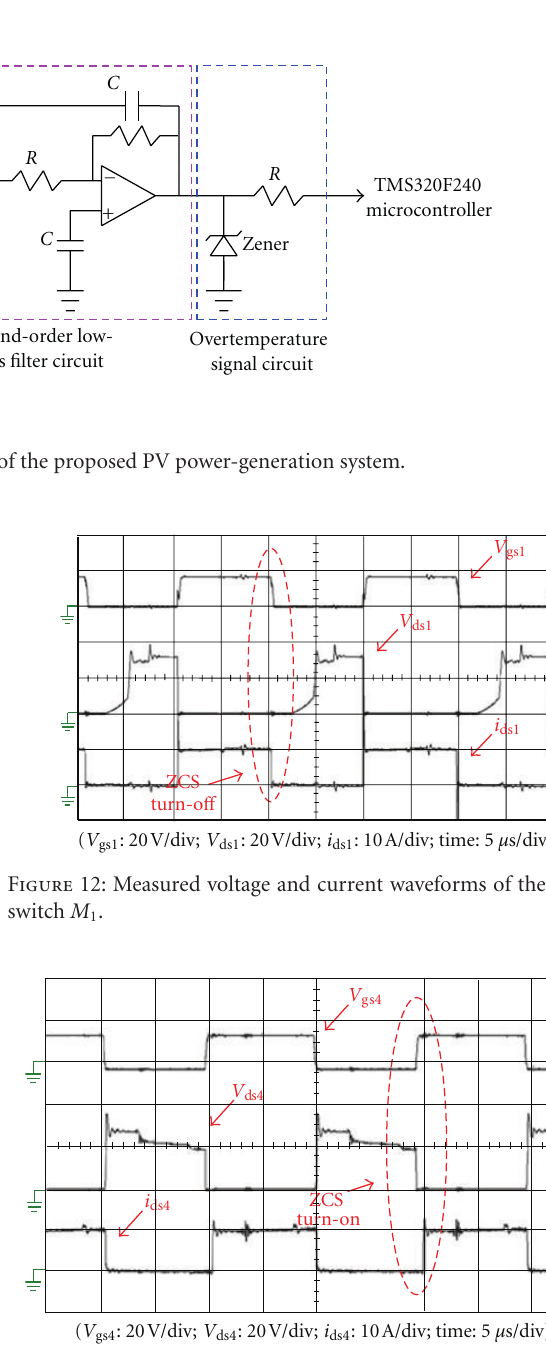
Figure 13: Measured voltage and current waveforms of the power switch M 4